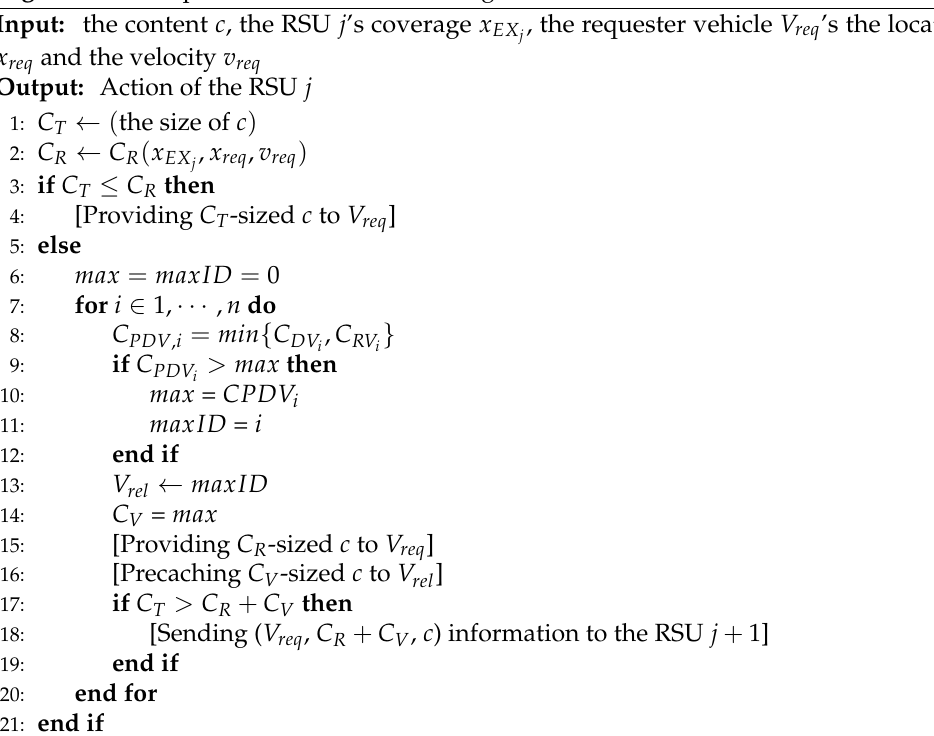
Algorithm 1 Cooperative Content